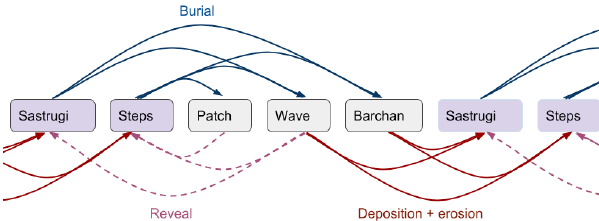
Figure 12. Observed interactions between erosional bedforms and bedforms made of loose snow. Left-to-right interactions result in the net deposition of new snow on the surface. “Burial” (blue): a wave, dune, or patch advects onto an eroded surface and covers the existing bedforms. “Reveal” (dashed): the wave, dune, or patch con- tinues traveling and leaves the observed area without modifying the surface. “Deposition + erosion” (red): a wave, dune or patch de- posits a layer of freshly accreted snow onto the surface. Erosional bedforms are carved immediately in the fresh